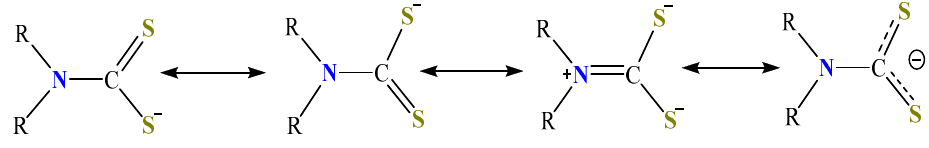
Figure 1. Dithiocarbamate resonance structures.